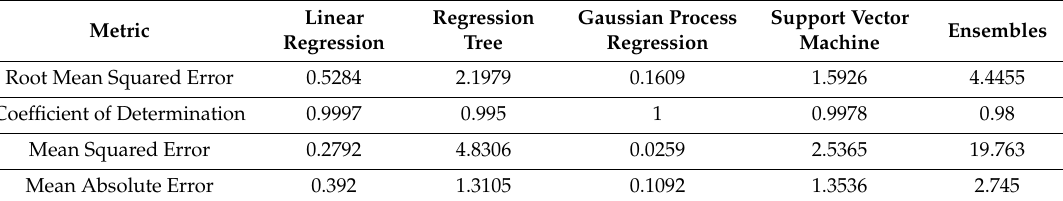
Table 5. Evaluation of the performance of five regression models used to predict the value of the temperature of the liquid aluminum.